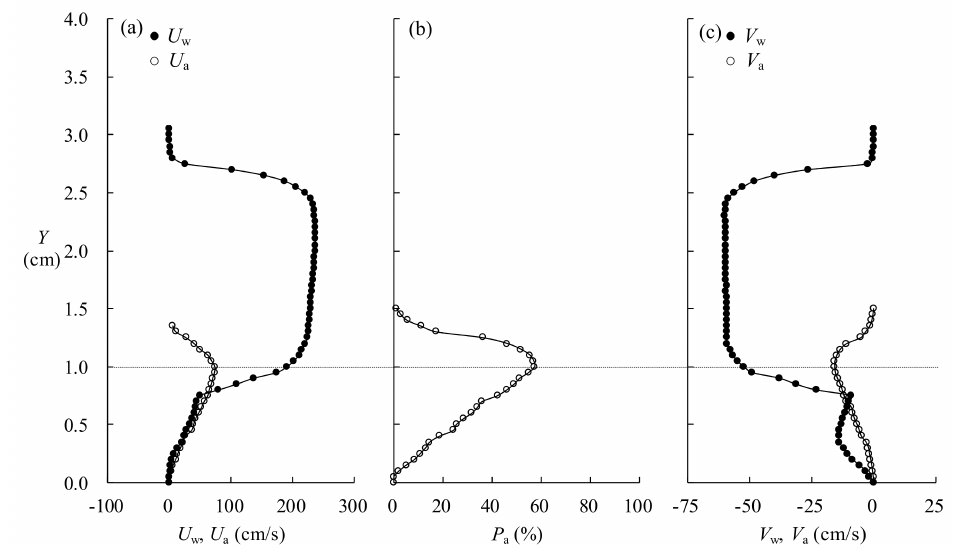
Figure 25. Relationship among ( a ) the profiles of mean streamwise velocities of both water stream and air-bubble phases, ( b ) the probability distribution for intermittent occurrence of air bubbles, and ( c ) the profiles of mean transverse velocities of both phases at X = 15.05 cm.